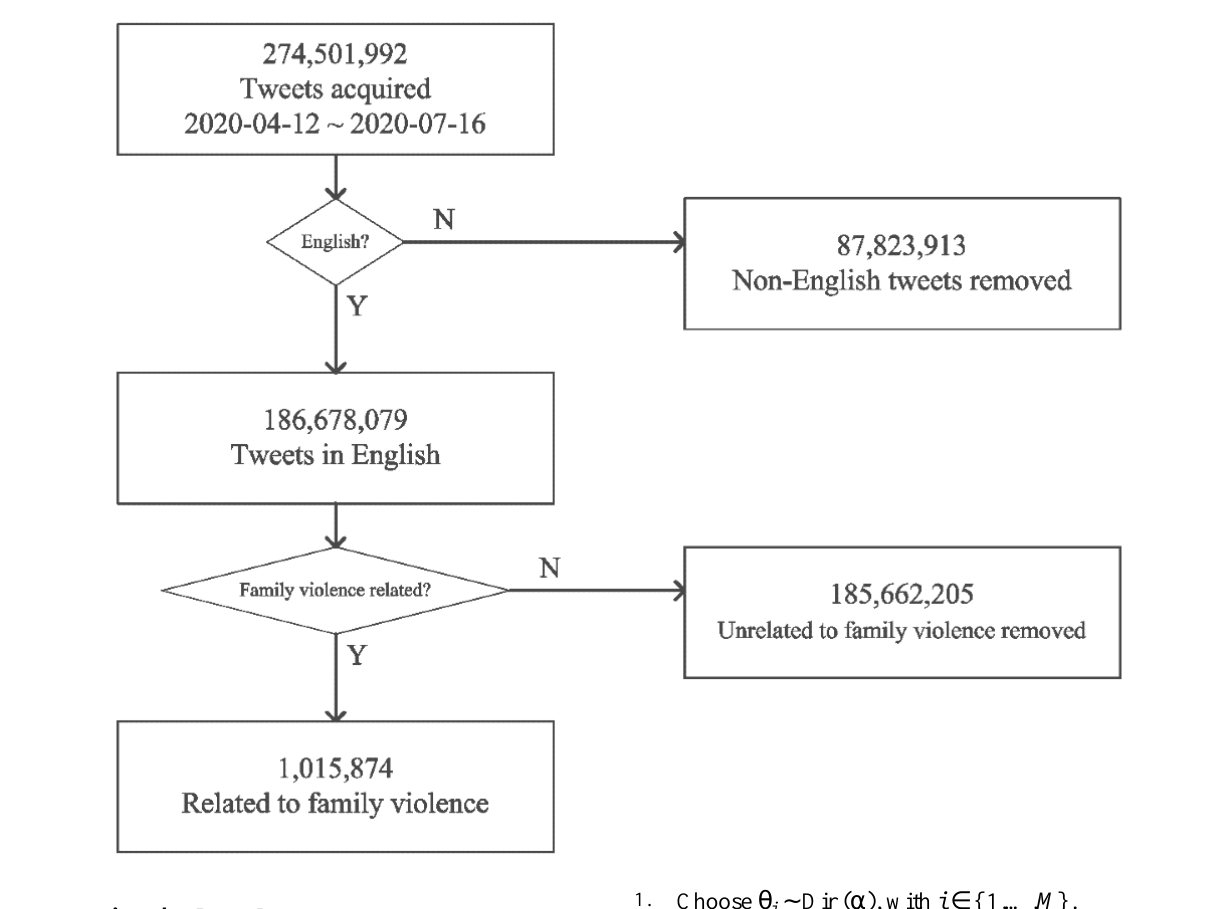
Figure 1. Tweets preprocessing